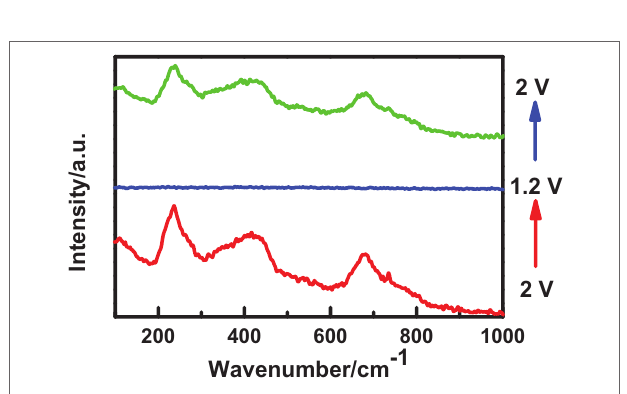
FigUre 7 | Raman spectra of Li 4 Ti 5 O 12 electrodes measured by using different laser sources, with the laser wavelength of 532 and 780 nm for the blue and red curves,